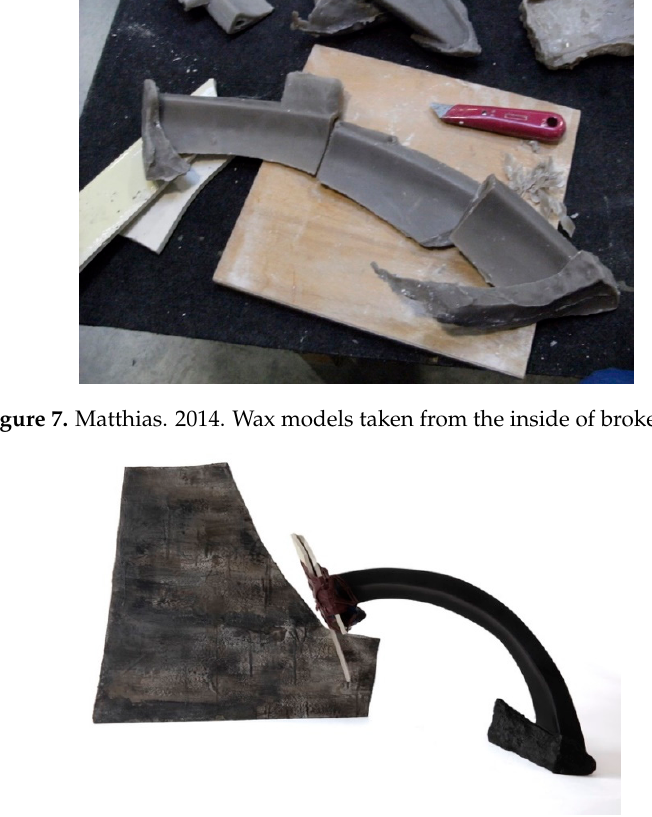
Figure 8. Matthias. 2015. Land Marks II .